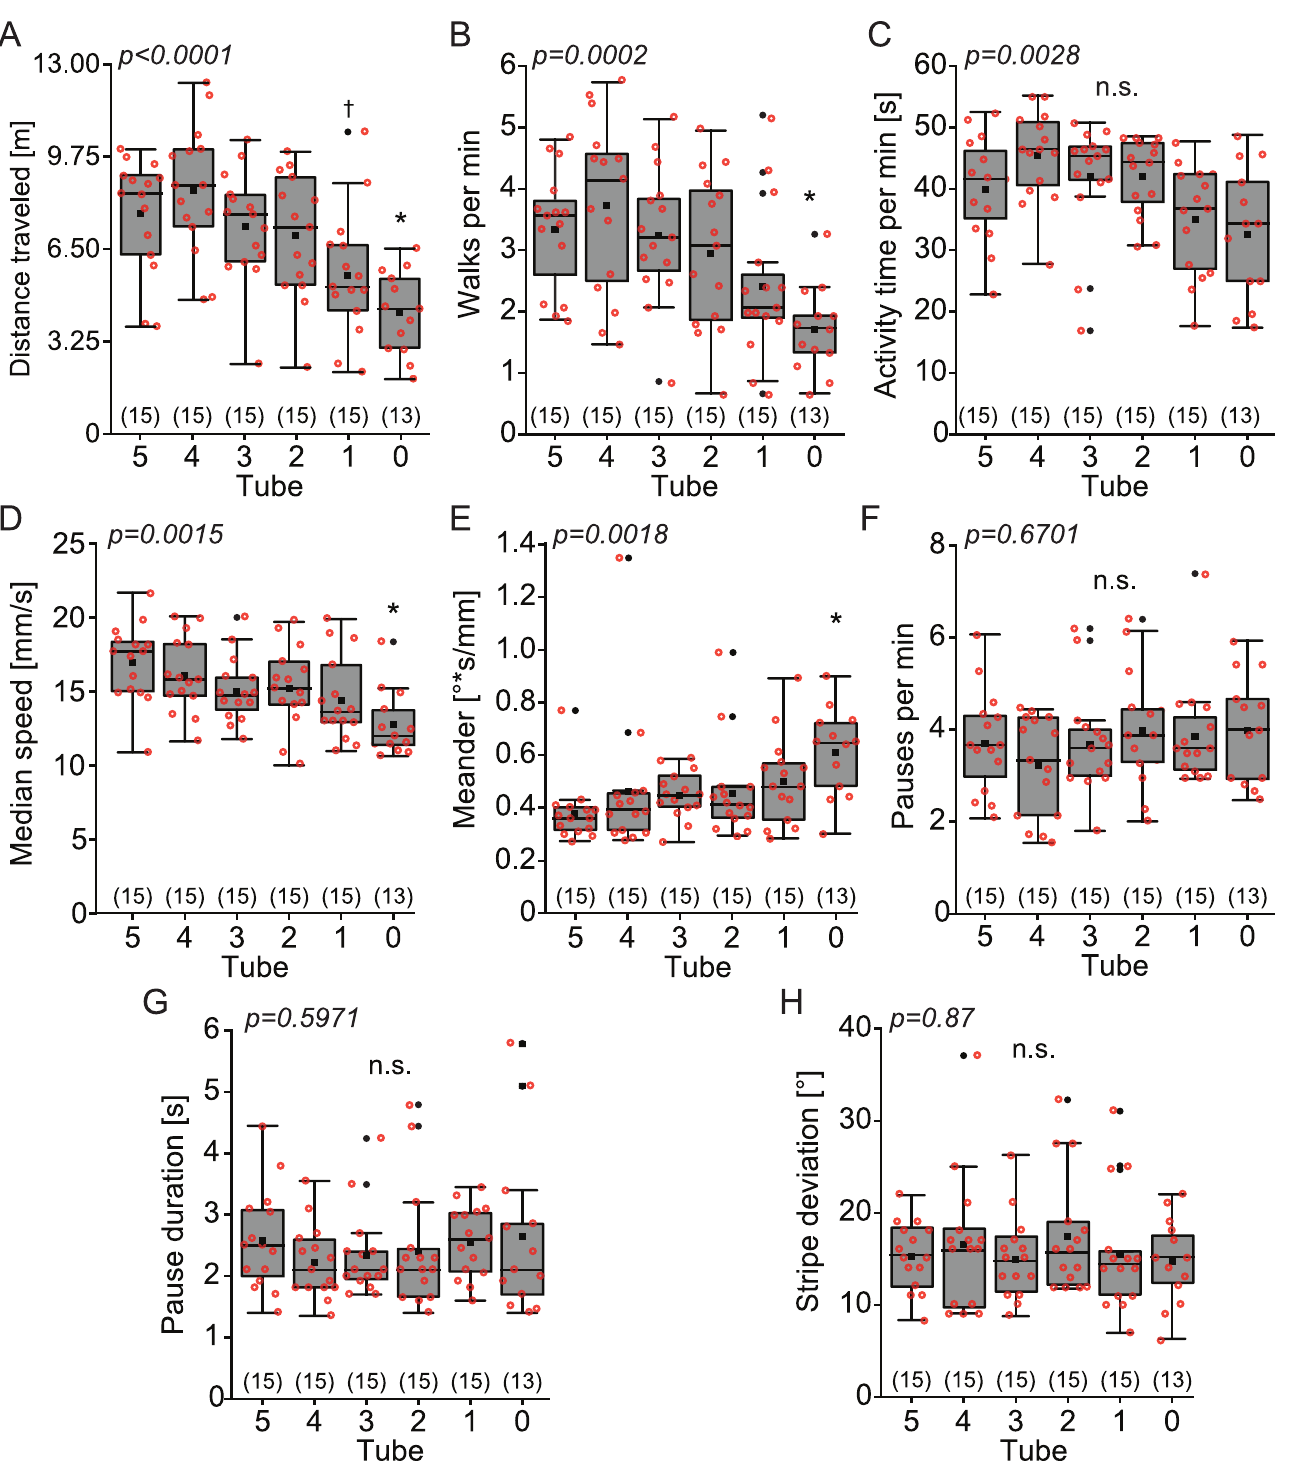
Fig 4. Less phototactic flies show reduced activity in Buridan’s paradigm. Groups of 80 flies were tested in Buridan’s paradigm after they were fractionated according to their phototaxis in CPP. Higher tube number indicates stronger phototaxis. (A) Total distance travelled during the experiment. p < 0.005 with. � compared with tubes 5, 4, and 3; † compared with tube 4. (B) Number of walks between the stripes. p < 0.005 with � compared with tubes 5, 4, and 3. (C) Activity time per minute. Kruskal-Wallis significant, p < 0.005, Rank test not significant. (D) Median walking speed. p < 0.005 with � compared with tube 5. (E) Meander, a measure for the tortuosity of the fly’s trajectory. p < 0.005 with � compared with tube 5. (F) Pauses per minute. Not significant. (G) Pause duration. Not